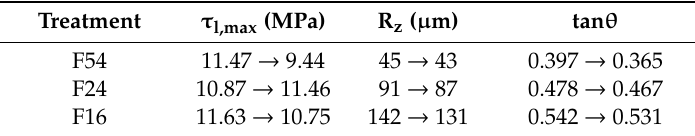
Table 7. Change in test results and roughness parameters (blasting (3 bar) → combined blasting (3 bar) and etching (5 min, NaOH) treatment, 5 µ m tip).